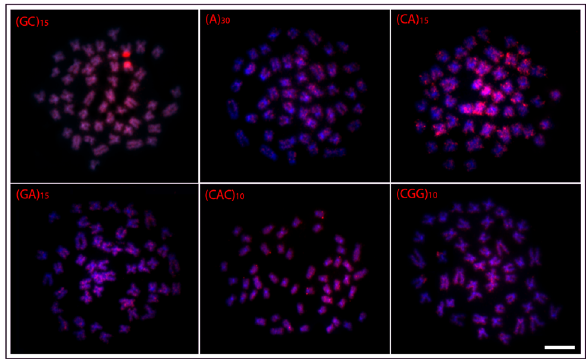
Figure 7 – Hybridization patterns with microsatellites probes (red signals) on metaphase plates of the Osteochilus waandersii . Chromosomes were counterstained with DAPI (blue). Scale bar = 5